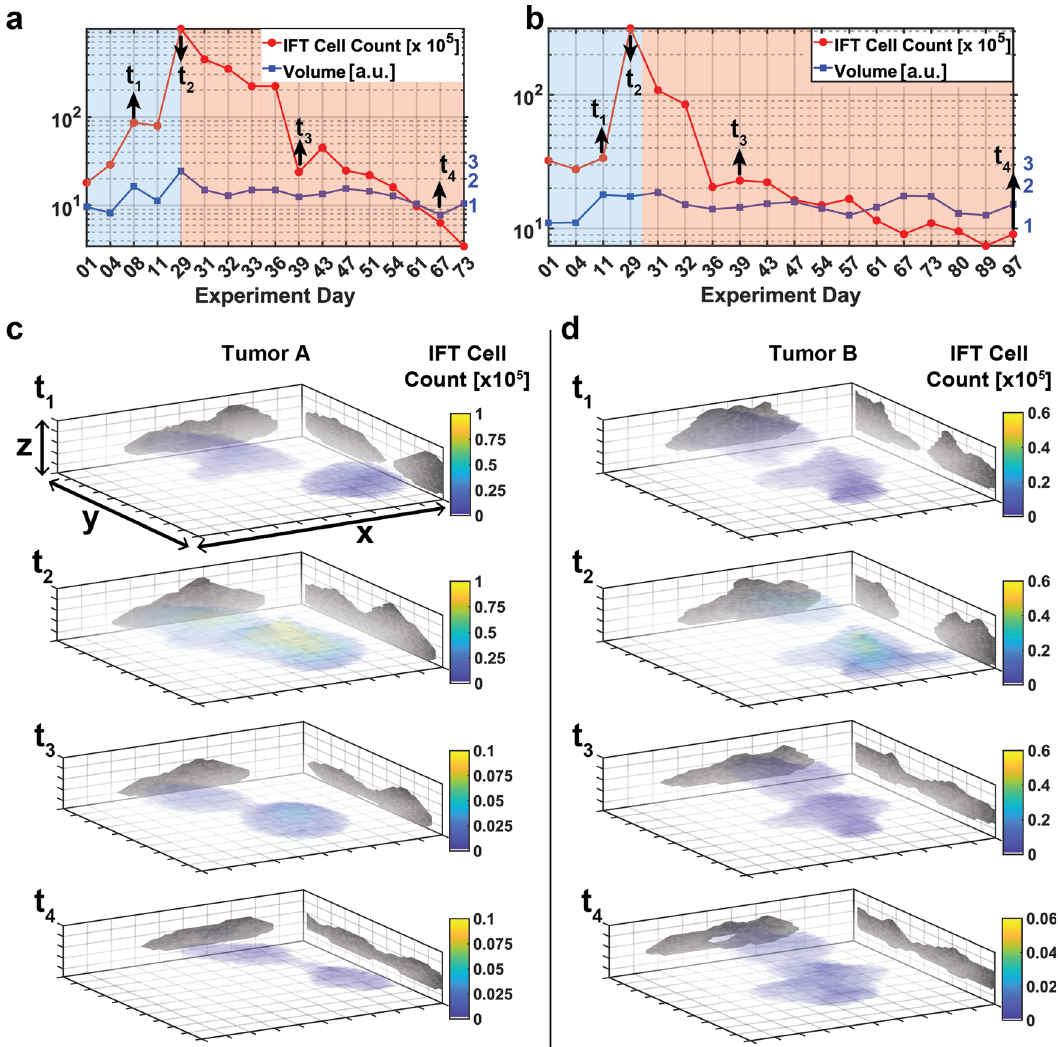
Fig. 4 Longitudinal molecular imaging of tumor development using IFT. a , b depict longitudinal IFT data of cell count and tumor volume for two ( n = 2) independent animals. Left axis indicates the cell count and right axis indicates relative (normalized) volume change. Blue background indicates Doxycycline administered time-frame (tumor growth), while red background indicates Doxycycline-free time-frame (tumor regression). c , d 3D IFT reconstructions corresponding to selected time-points. All tumors were reconstructed over the same volume, ( x , y , z = 11 × 11 × 2 mm 3 ). Color bars represent the IFT cell count per (Fig. 3d) indicates a detectable signal levels on the order of a few thousand cells. Finally, IFT reconstructions and histological slices of the same tumor show considerable morphological overlap, further corroborating the capability of IFT to faithfully capture the 3D tumor geometry and volume (Fig. 3c, right). Also see Supplemen- tary Fig. 3 for a slice-by-slice visualization of IFT 3D reconstructions.